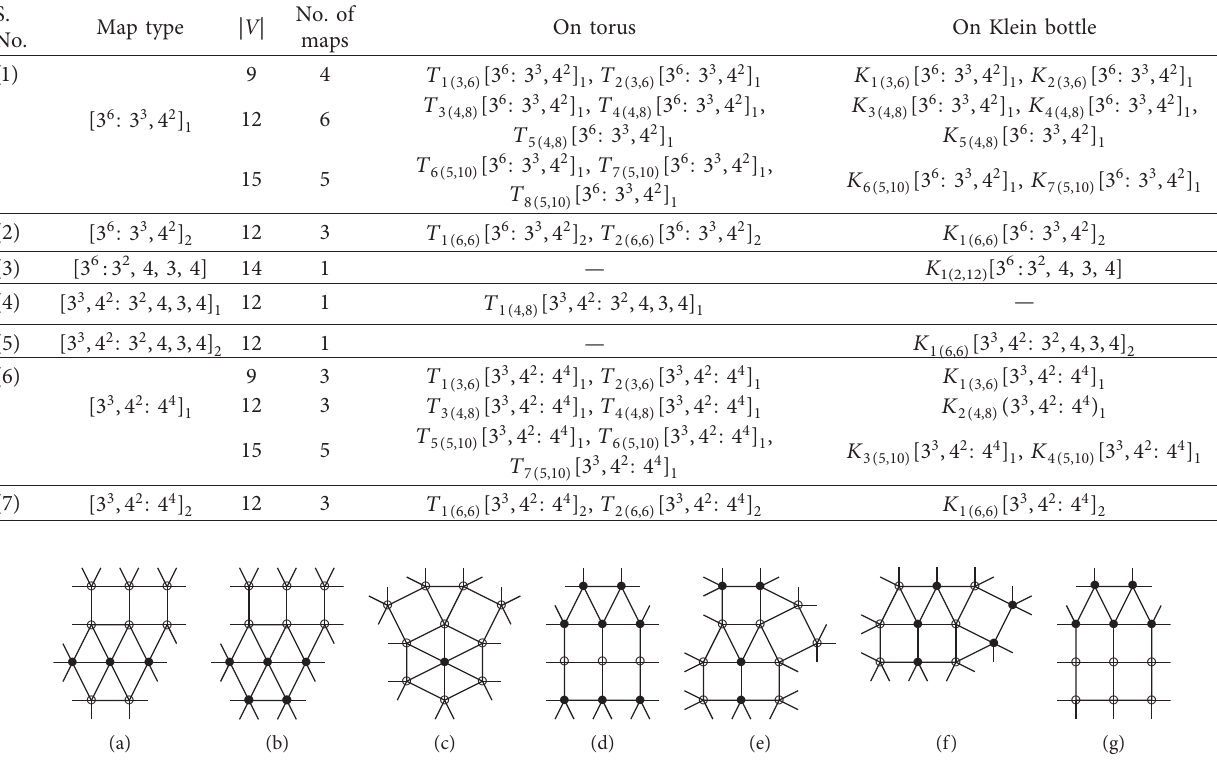
Figure 1: 2-uniform tilings of types: [ 3 6 : 3 3 , 4 2 ]